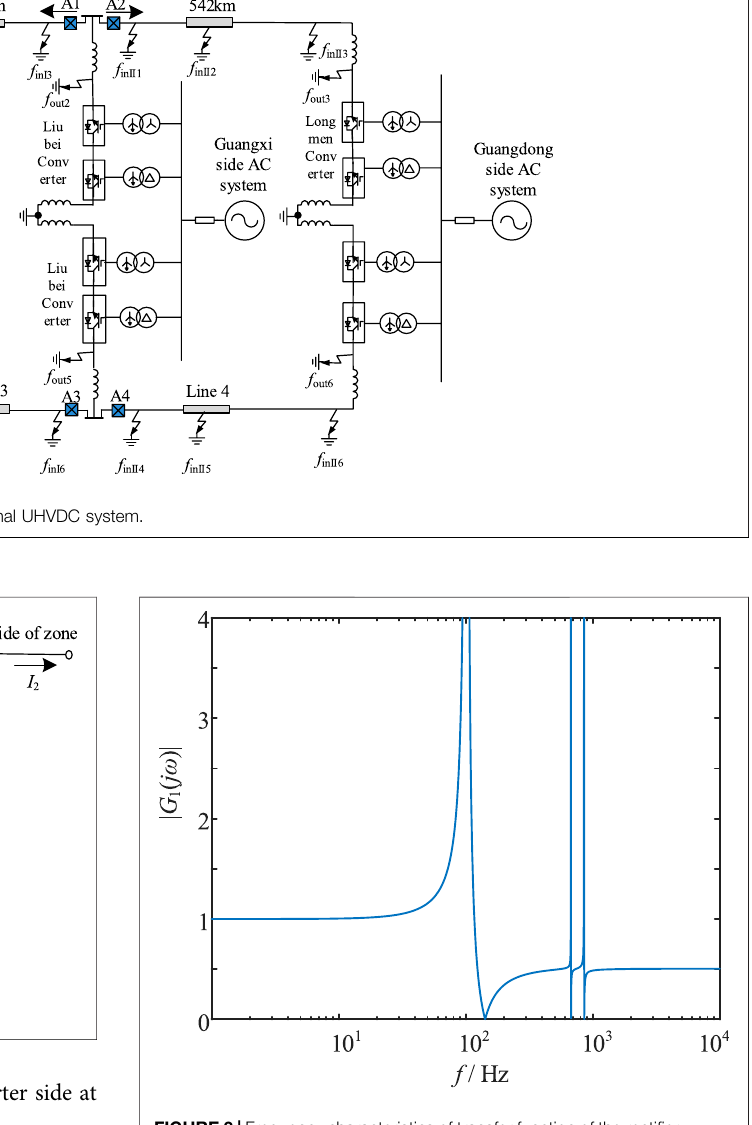
FIGURE 3 | Frequency characteristics of transfer function of the recti fi er side of the